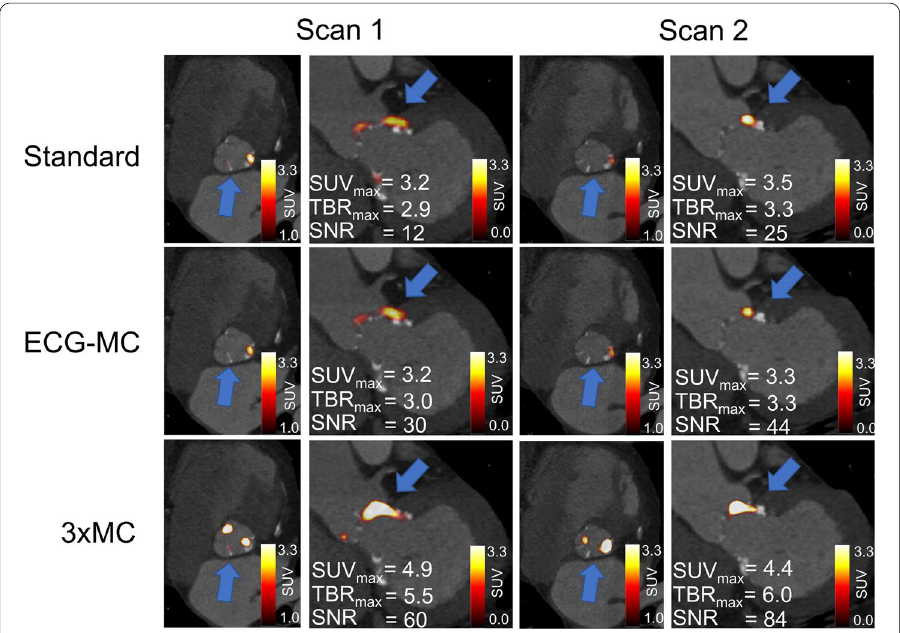
Fig. 7 Test–retest valve PET imaging for a patient before and after motion and background blood pool corrections. Standard and ECG-MC images present less specific uptake patterns at the areas with calcification, while 3 MC images show reproducible uptake patterns for the two scans. ECG-MC cardiac contraction × = motion-corrected, 3 MC triple motion-corrected, SUV max maximum standardized uptake value, × = = TBR max maximum target-to-background ratio, SNR signal-to-noise = =